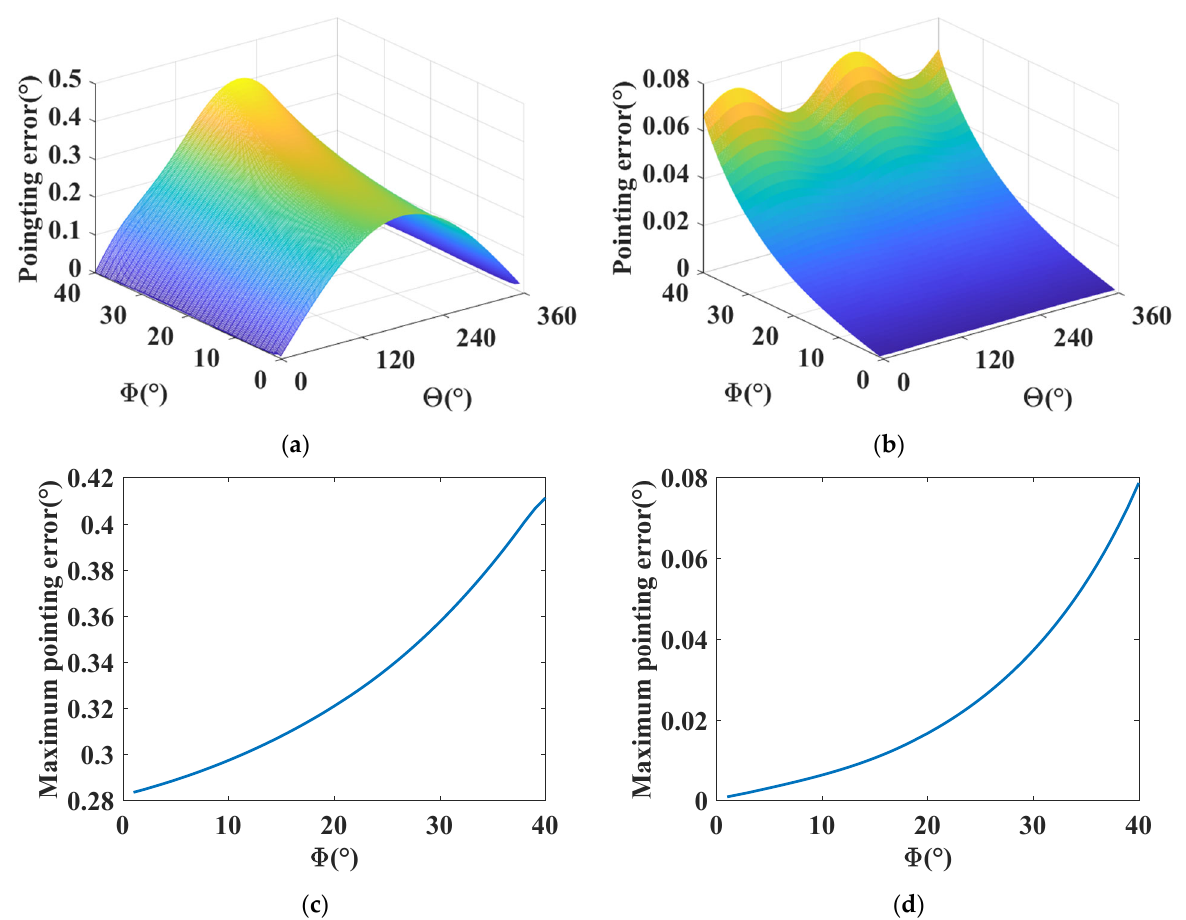
Figure 10. Simulation results of inverse solution error correction. ( a ) Inverse solution error in the whole pointing field before correction. ( b ) Inverse solution error in the whole pointing field after correction. ( c ) Maximum error in each deflection angle before correction. ( d ) Maximum error in each deflection angle after correction.